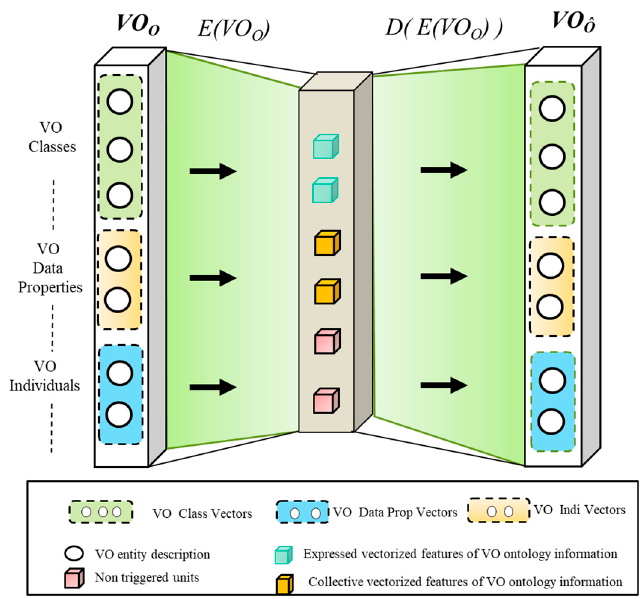
Figure 10. Representation of the learning model.